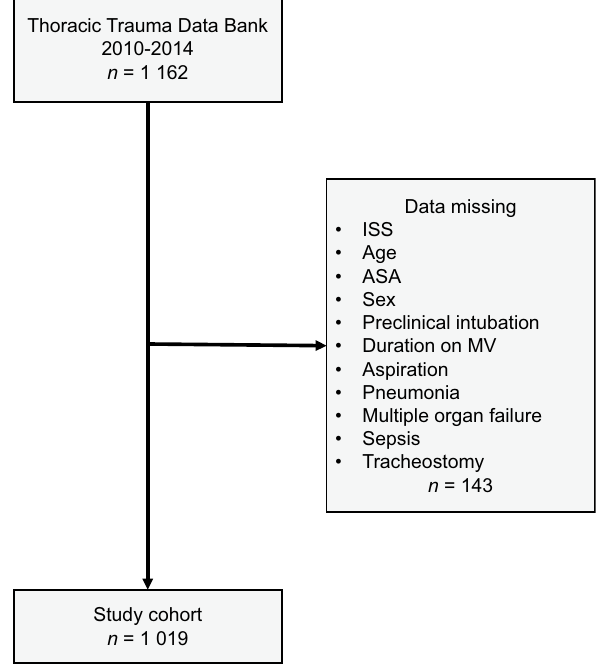
Figure 1. Flow chart indicating the inclusion and exclusion